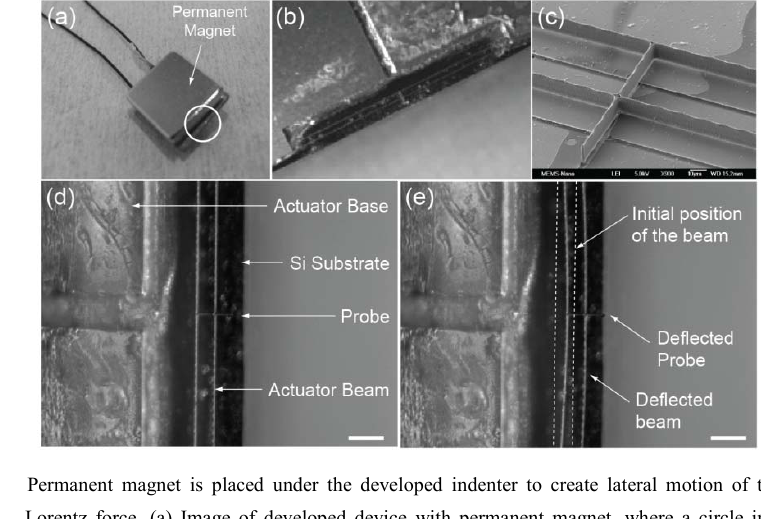
Permanent magnet is placed under the developed indenter to create lateral motion of the probe by Lorentz force. (a) Image of developed device with permanent magnet, where a circle indicating the location of the indenting probe. (b) Enlarged image of the actuation beams. (c) SEM image of developed probe. Actuation of the device is shown in (d) and (e), where the device is supplied with 1.335 V, 75.14 mA, resulting in approximately 40 μ m of beam